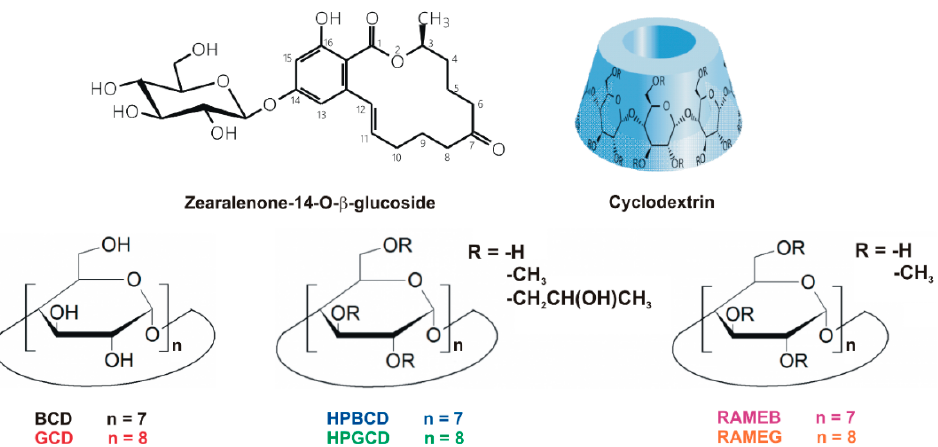
Figure 1. Chemical structures of zearalenone-14- O- β - D -glucoside (Z14G) as well as native, randomly methylated (DS = 12), and hydroxypropyl (DS = 4.5) β - and γ -CDs (BCD, β -cyclodextrin; GCD, γ -cyclodextrin; HPBCD, (2-hydroxypropyl)- β -cyclodextrin; HPGCD, (2-hydroxypropyl)- γ -cyclodextrin; RAMEB, randomly methylated β -cyclodextrin; RAMEG, randomly methylated γ -cyclodextrin; DS: average degree of substitution per CD ring).